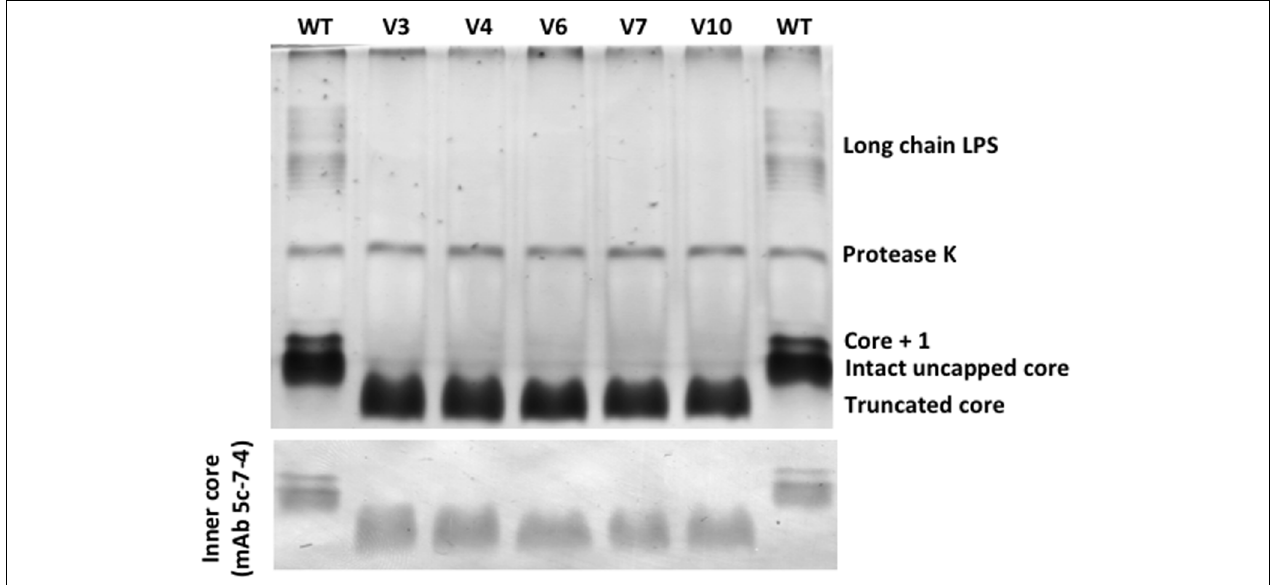
FIGURE 4 | SDS–PAGE and Western immunoblots (probed with mAB 5c-7-4) of LPS from P. aeruginosa PAO1 wild-type (WT) and five phage-resistant variant strains (V3, V4, V6, V7, and